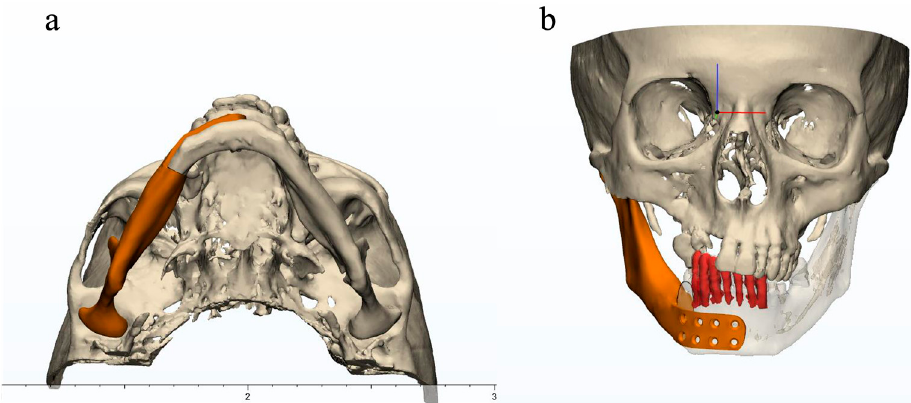
Figure 4. Simulation of the general shape of the mandibular prosthesis delineated from the mirrored image of the unaffected side on 3D models. ( a ) inferior view; ( b ) frontal view.